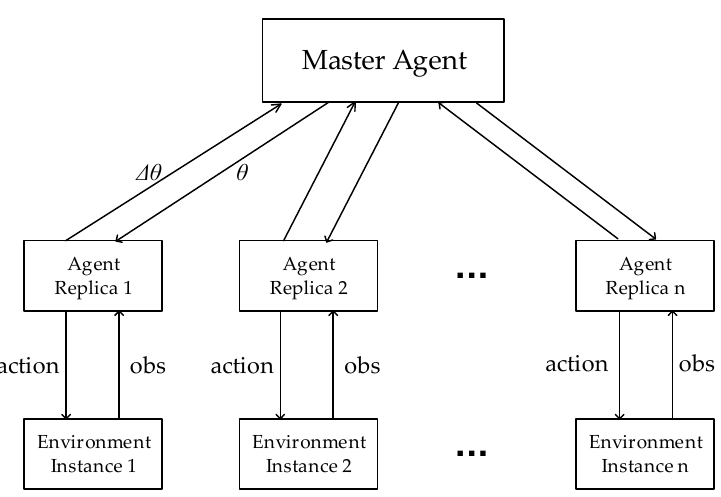
Figure 3. The diagram of Asynchronous Advantage Actor-Critic (A3C).